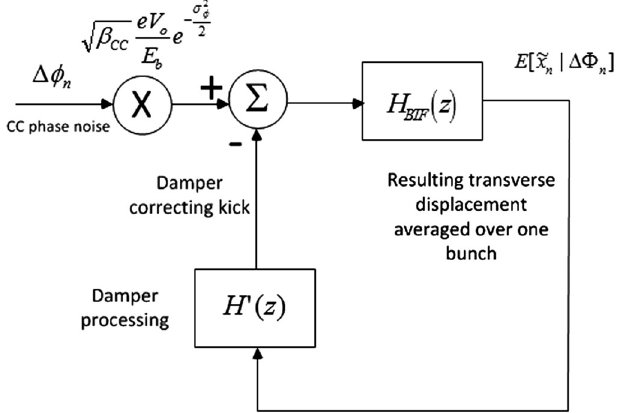
FIG. 19. Block diagram showing the transfer function between E ½ ~ x n j Δ Φ and phase noise in the presence of n (cid:3)